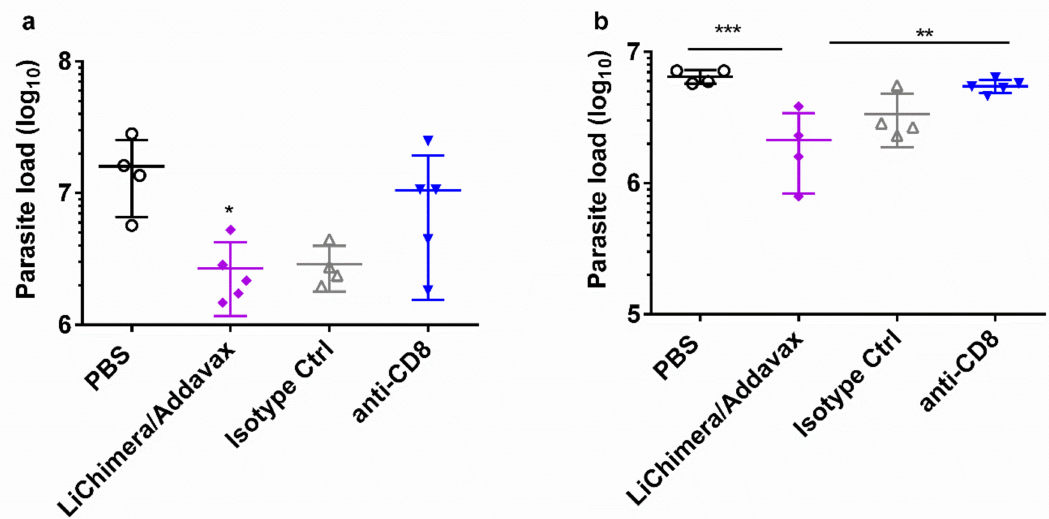
Figure 13. Role of CD8 + T cells protection against L. infantum in LiChimera / Addavax vaccinated mice. The BALB / c mice were vaccinated twice intramuscularly with LiChimera adjuvanted with Addavax. Two weeks post boosting, mice were challenged with 1 × 10 7 stationary phase L. infantum promastigotes. Mice were treated the day before L . infantum challenge and again on day 2 using anti-CD8 + monoclonal antibody. The control mice were treated with normal rat IgG. As the control for infection, PBS-injected mice were also included. The parasite load in liver ( a ) and spleen ( b ) was measured 8 weeks post challenge. Data are expressed as means ± s.d. for n = 4–5 mice per group. Significant di ff erences between groups are indicated with asterisks measured by one-way ANOVA and Tukey’s